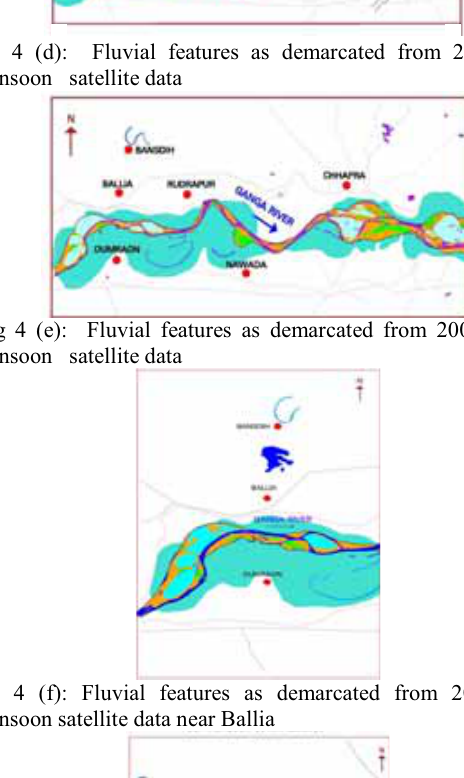
Fig 4 (a): Fluvial features as demarcated from SOI maps